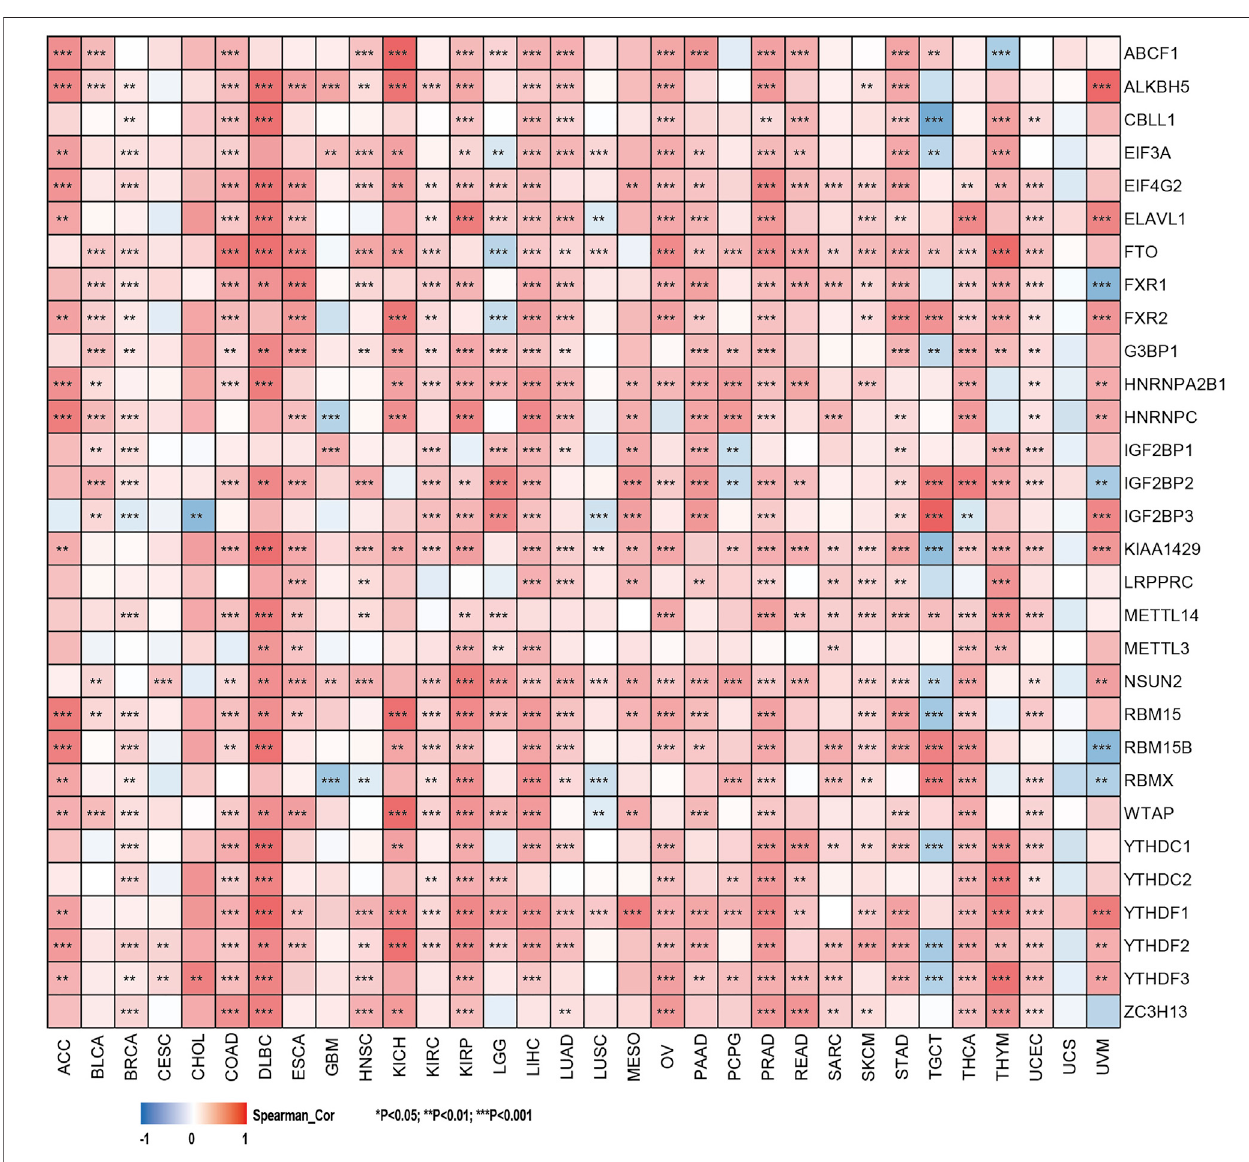
FIGURE 5 | Correlation of SHC1 gene expression levels with the most common m6A RNA modi fi cation regulator levels in pan-cancer.